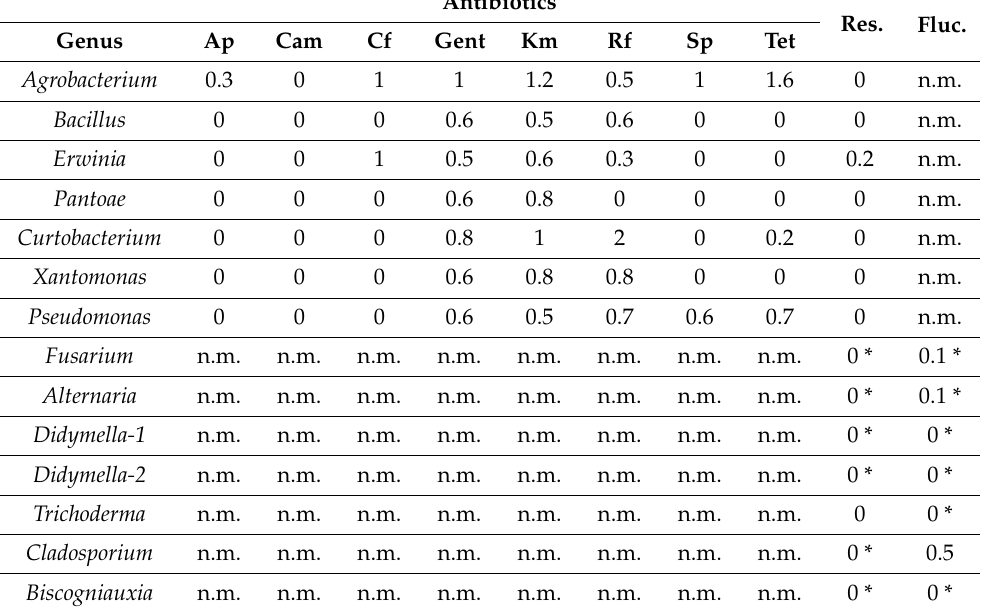
Table 3. Analysis of the sensitivity of endophytic bacteria and fungi of Vitis amurensis to antibi- otics and trans -resveratrol. The values are given as the distance (cm) from the antibiotic-soaked paper disk to the visible bacterial growth zone. Ap—ampicillin (50 mg/L), Cam—chloramphenicol (35 mg/L), Cf—cefotaxime (250 mg/L), Gent—gentamicin (50 mg/L), Km—kanamycin (50